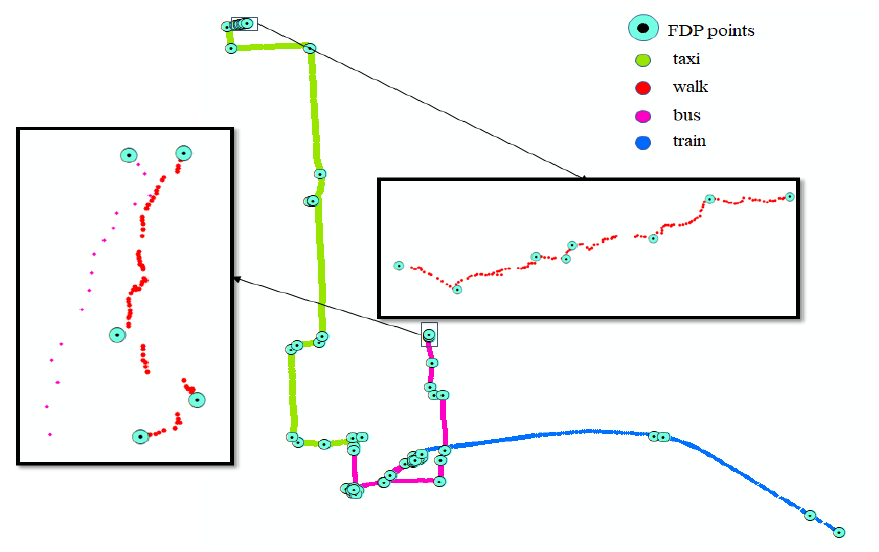
Figure 10. FDP trajectory compression with flexible